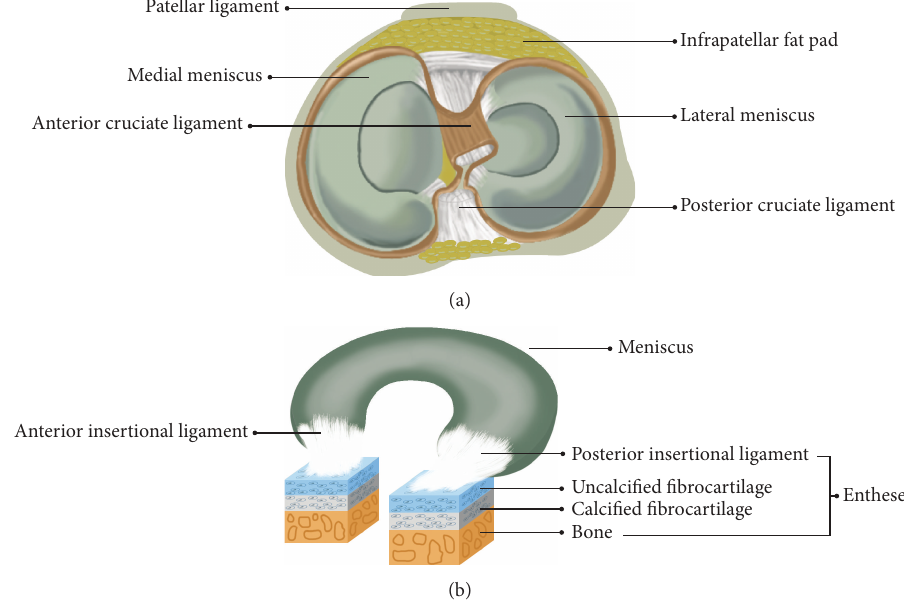
Figure 1: Top view of the anatomical meniscus (a): lateral meniscus is “O” shaped, whereas the medial meniscus has a “C” appearance. The meniscalfunctionalunit(b),includingthecorrespondinganteriorandposteriorligamentsandentheses.Enthesestypicallycontainligaments, uncalcified fibrocartilage, calcified fibrocartilage, and